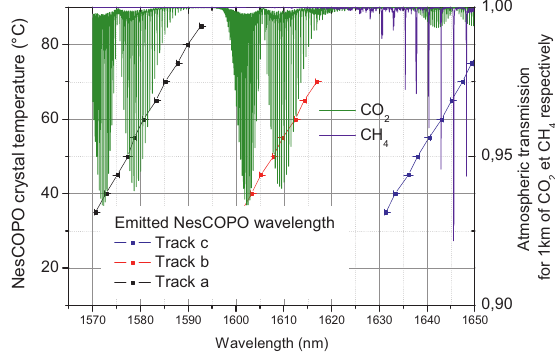
Fig. 1. NAOMI GAZL NesCOPO emitted wavelength as a function of the PPLN temperature, for three different poling periods a).